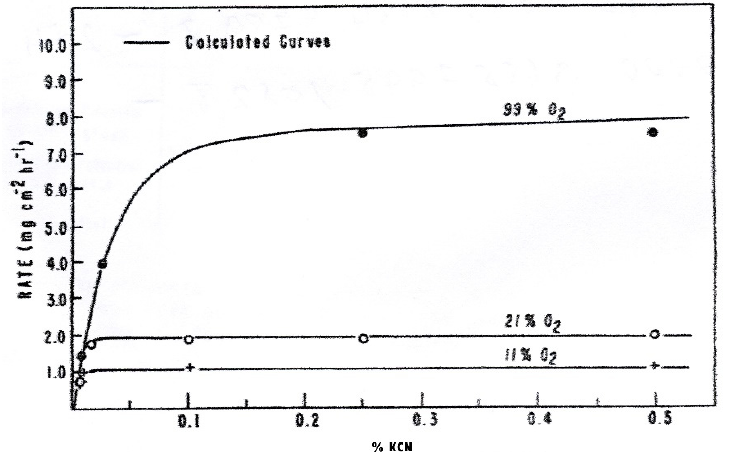
Figure 4. Rate of dissolution of Au at various KCN concentrations for three O 2 /N 2 gas mixtures showing correlation of measured [43] and calculated rates. showing correlation of measured [43] and calculated